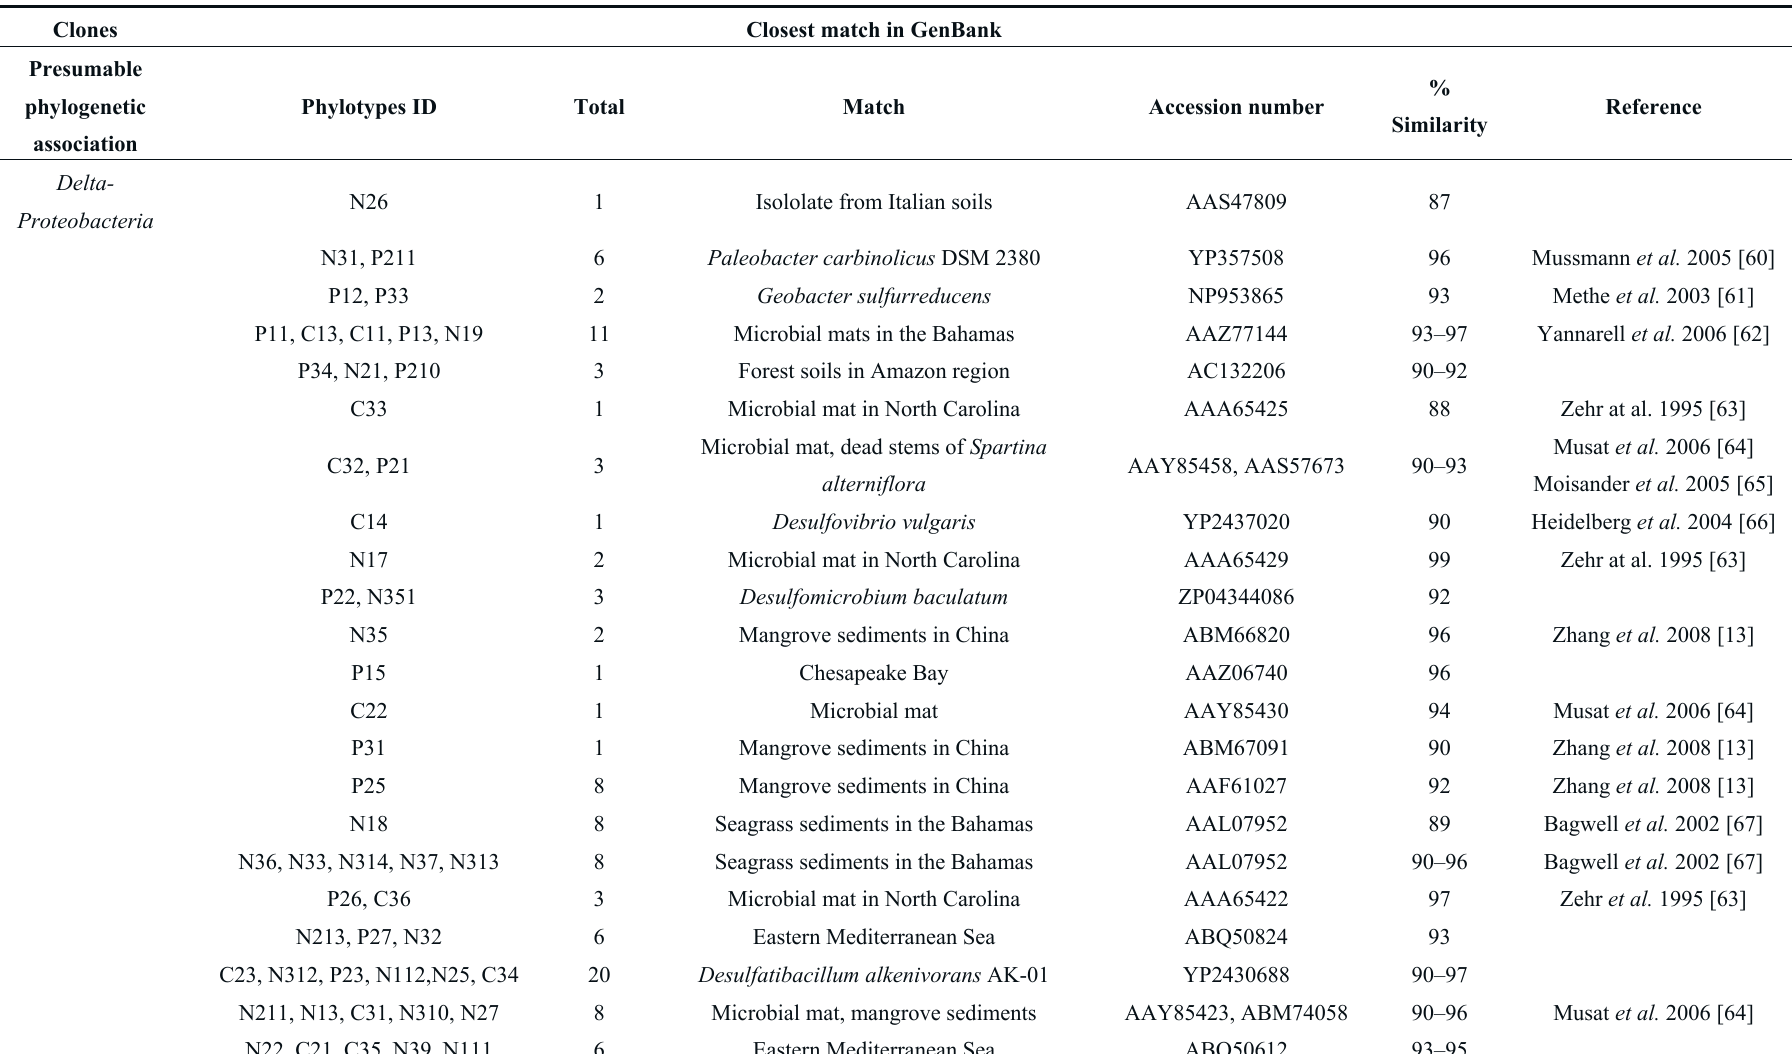
Table 1. Summary of the closest matches for nifH sequences of nitrogen-fixing bacteria from mangrove sediment samples. Letters in the phylotypes ID refer to the nutrient treatment where the clone was found (control: Ctrl, phosphorus: P, and nitrogen: